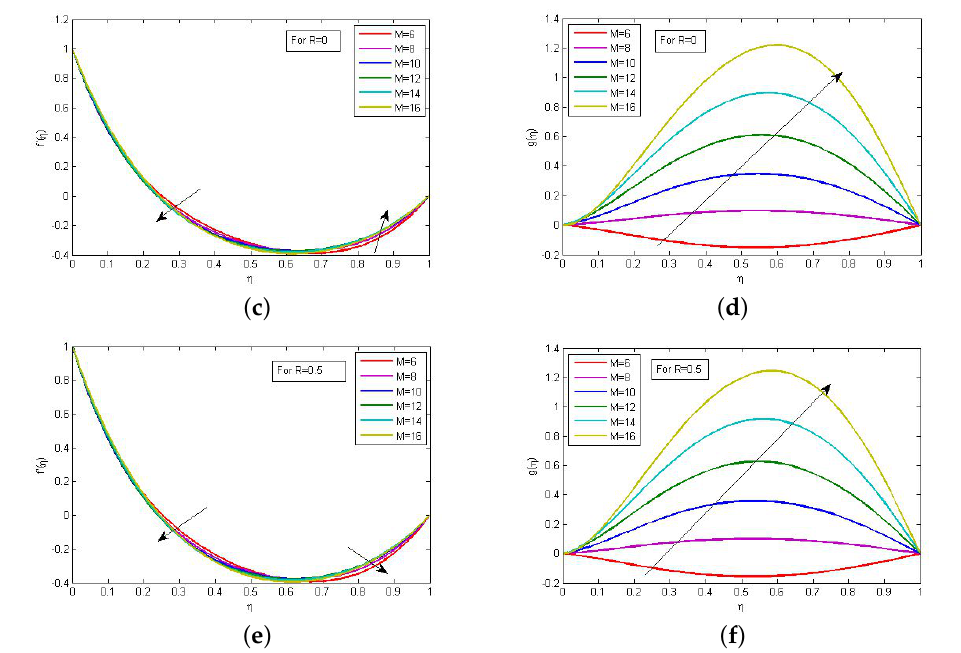
Figure 3. Impact of M on f (cid:48) ( η ) for cases ( a ) R = 1.0 ( c ) R = 0.0 ( e ) S = 0.5, and of M on g ( η ) for cases ( b ) R = 1.0 ( d ) R = 0.0 ( f ) R = 0.5.